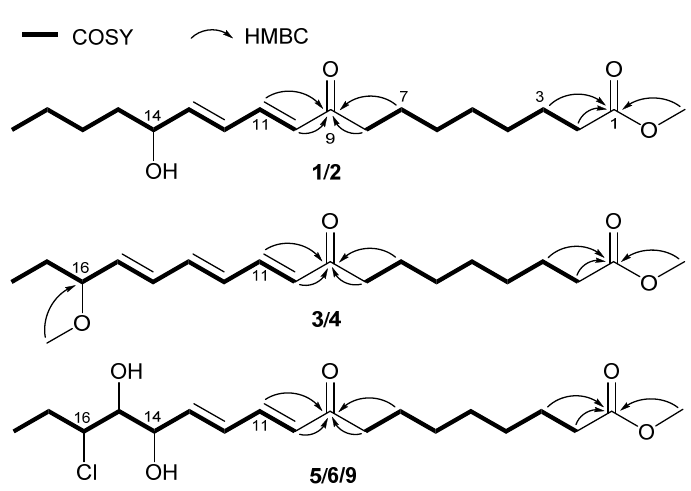
Figure 2. 1 H ‐ 1 H COSY and selected HMBC correlations for 1 – 6 and 9 .